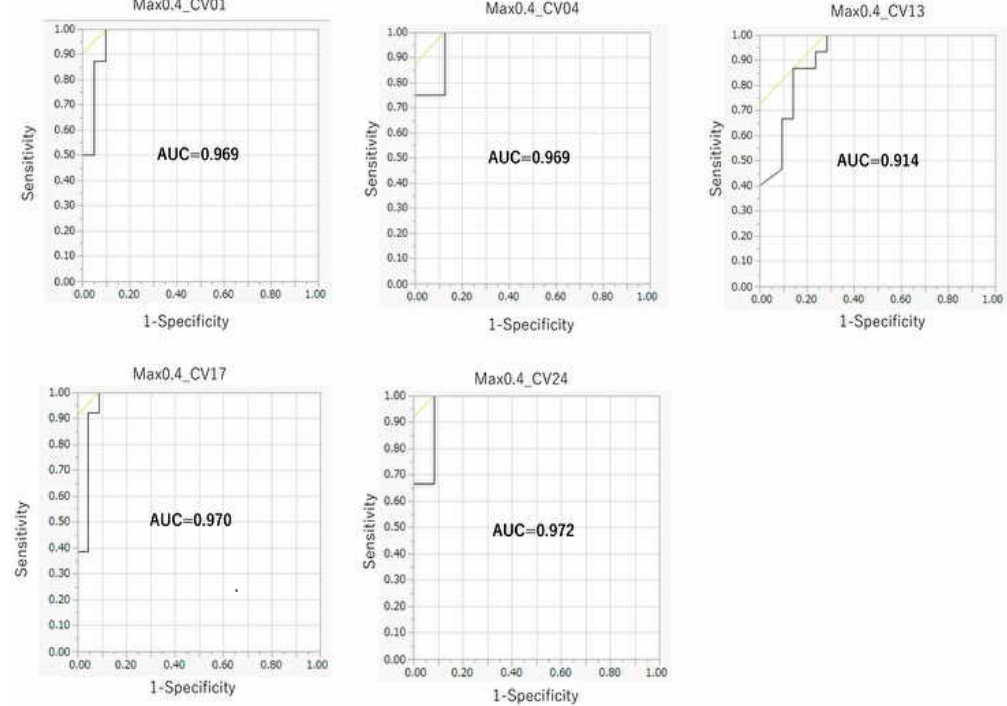
Figure 2. ROC of prediction models in the ≥ 40% threshold. CV01_MAX0.3, CV04_MAX0.3, CV13_MAX0.3, CV17_MAX0.3, and CV24_MAX0.3 represent each dataset in five-fold test.